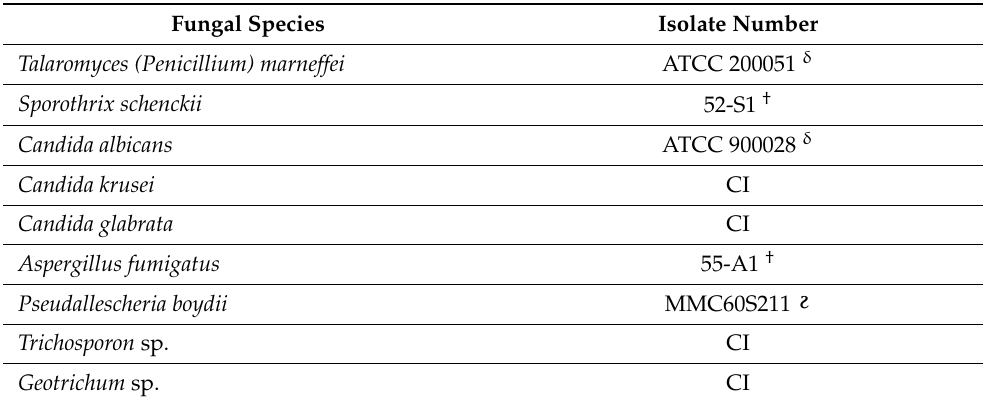
Table 1. Non-Cryptococcus fungal isolates